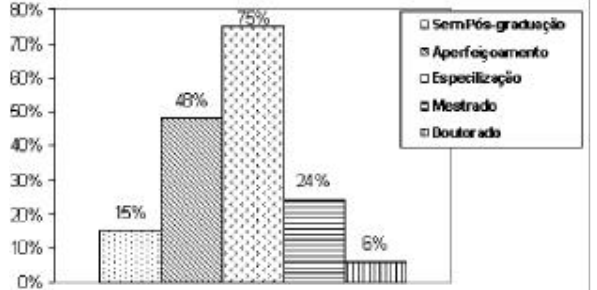
FIGURA 2- Distribuição das Cirurgiãs-dentistas, segundo o tipo de Pós-graduação cursado. Araçatuba, SP-2002.